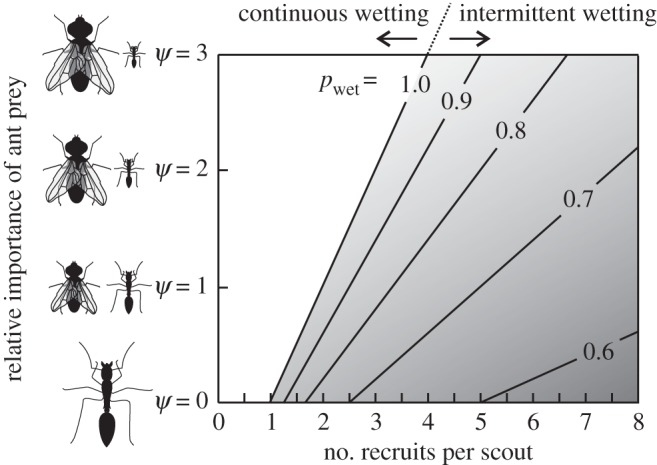
Predictions from a simple mathematical model (equation (4.1), plotted here for Ewet = 1) showing whether continuous or varying degrees of intermittent wetting maximize the pitchers' capture rate, depending on the recruitment rate of visiting ants and the relative importance of ants or other insects as prey. For example, if ψ = 1 (equal importance of ants and other prey) and if each ant recruits on average five further ants, the pitcher will catch the most prey if the peristome is wetted 70% of the time. ψ = nutritional importance of other prey compared to ants (for detailed definition see electronic supplementary material, appendix S3); pwet = probability of the peristome being wet. Lower pwet is favoured with increasing importance of ant prey and with higher recruitment rate.